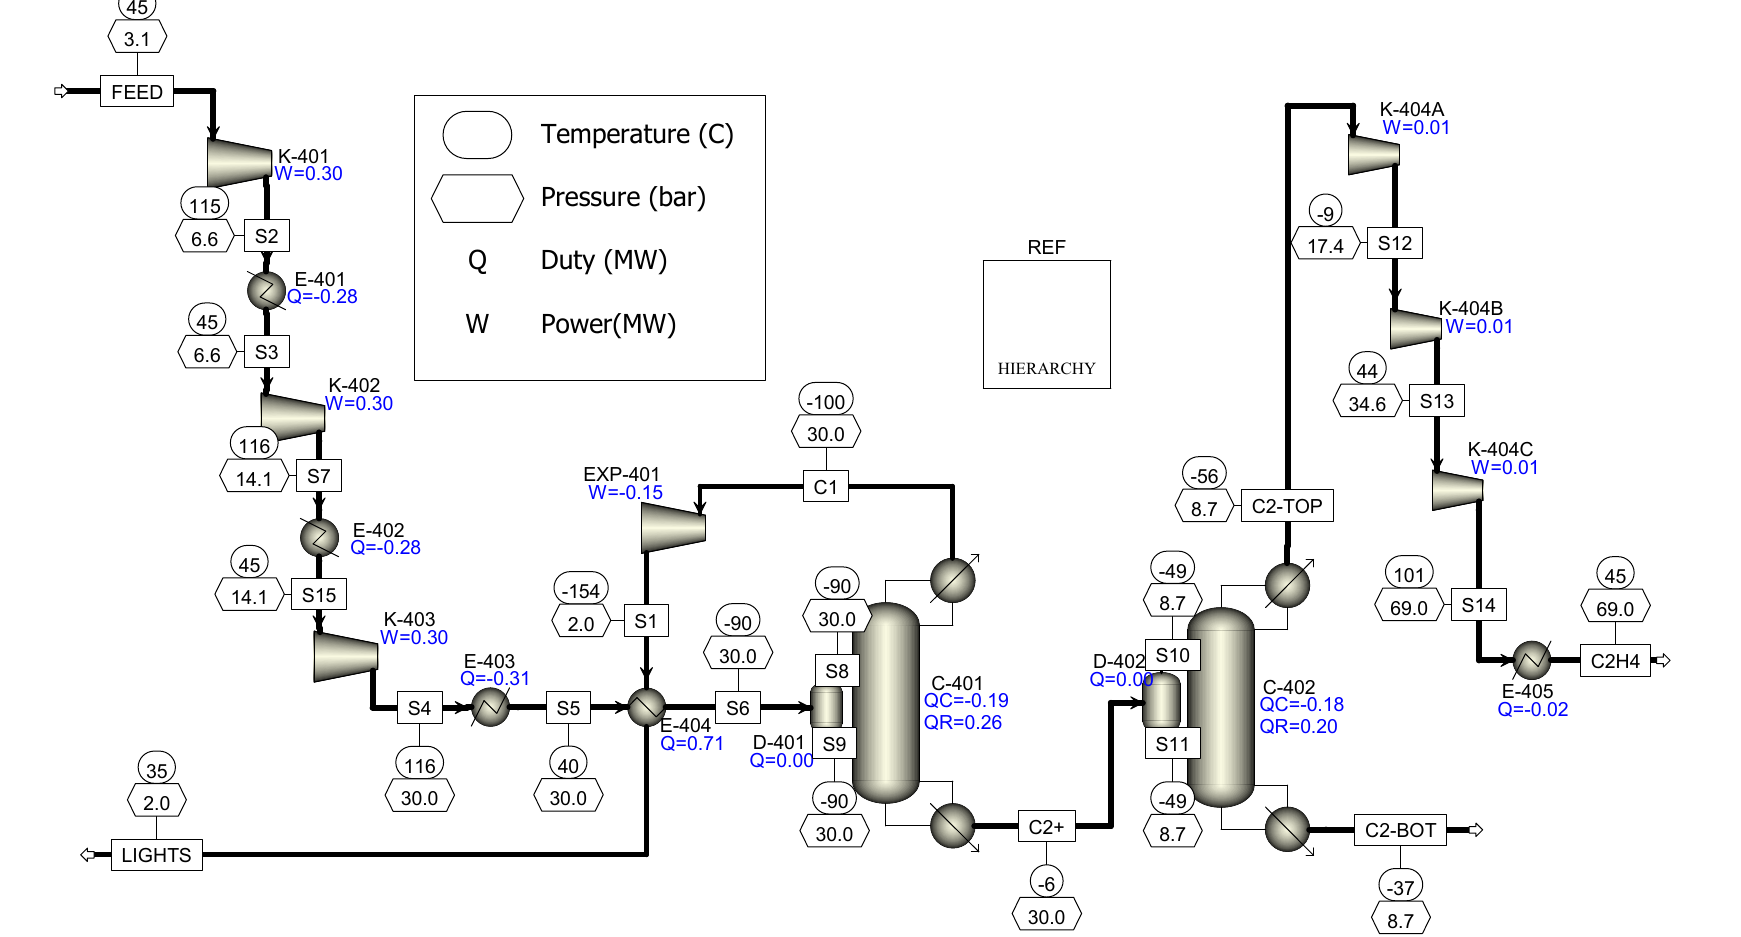
Figure 9. Process simulation of the traditional distillation configuration implemented in Aspen Plus software. Reproduced with permission from Penteado, Ph.D. Thesis, TUB, 2021